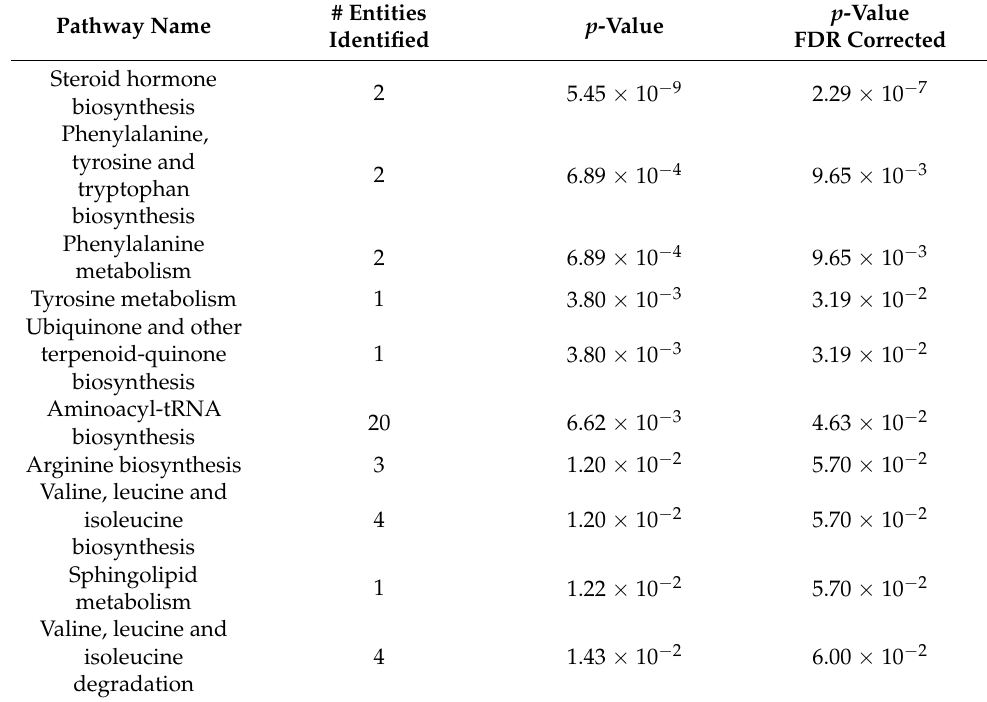
Table 4. Metabolomics: pathways identified as differentially expressed between COVID-19-positive participants treated with glucocorticoids and those not treated with